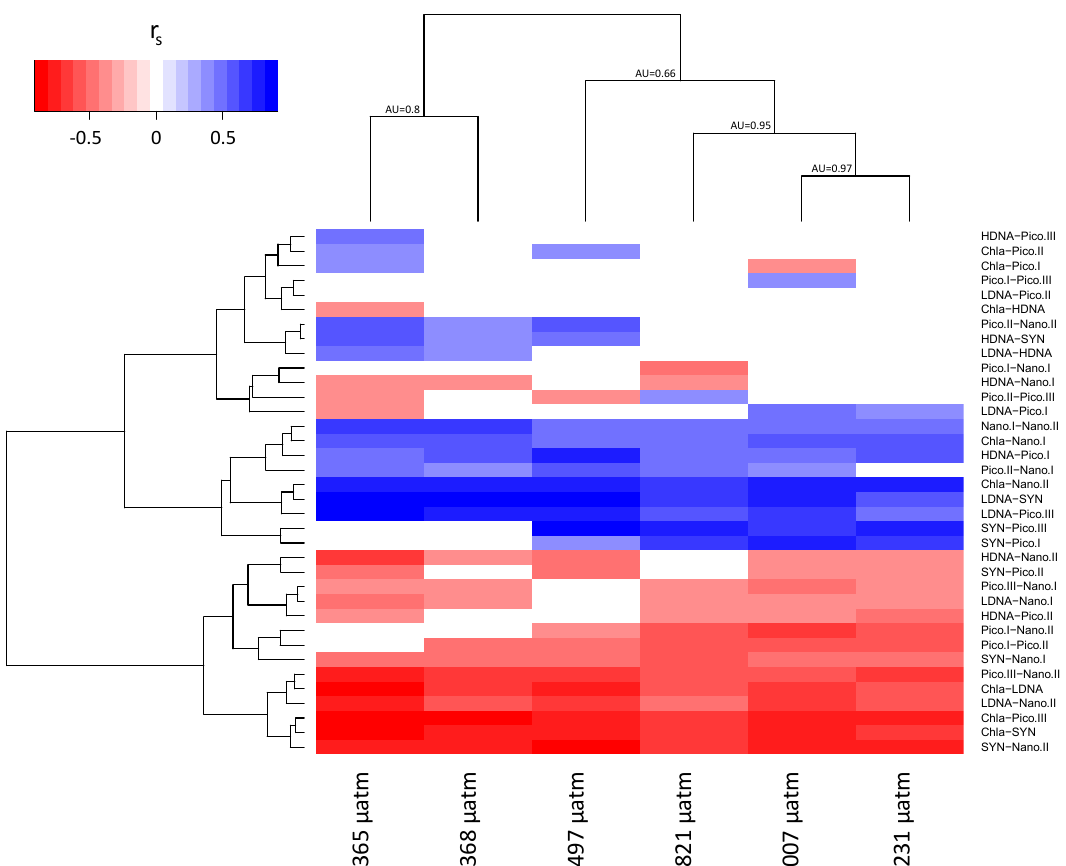
Figure 4. Heatmap and cluster analysis based on significant Spearman’s rank correlation coefficients calculated for each mesocosm between all possible combinations of abundances between different functional heterotrophic prokaryotic and phytoplanktonic groups (high and low nucleic acid-stained prokaryotic heterotrophs (HDNA:LDNA), Synechococcus spp. (SYN), picoeukaryotes I-III (Pico I-III), nanophyto- plankton I-II (Nano I-II)) and Chl a based on daily measurements between t 1 and t 39. Colours indicate the Spearman’r rank coefficient ( r s ) between two variables. P values of correlations were corrected for multiple testing according to Benjamini and Hochberg (1995). Uncertainty in hierarchical clustering was assessed with multiscale bootstrap resampling using approximately unbiased (AU) p values (between 0 and 1; Suzuki and Shimodeira, 2015). Clusters of the three highest f CO 2 treatments are significantly different at the 0.05 level. Numbers indicate the f CO 2 treatment with average f CO 2 [µatm] between t 1 and t